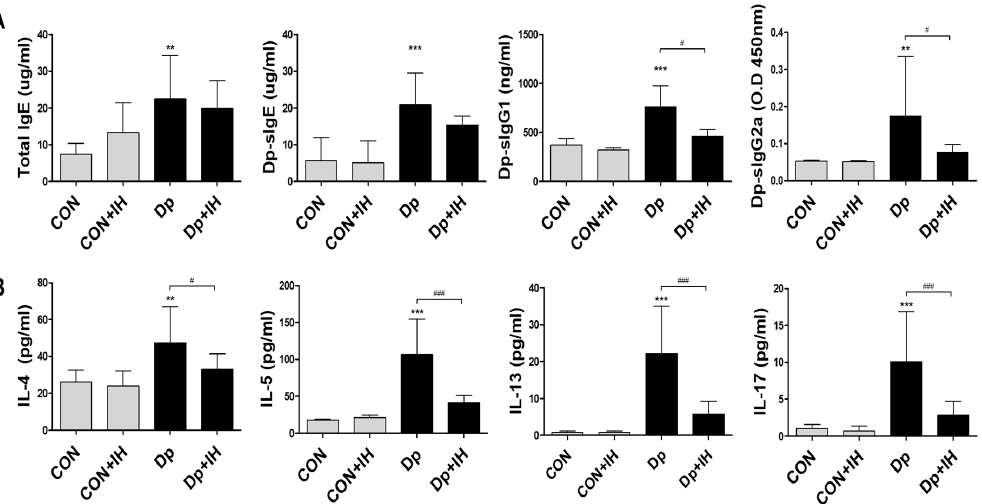
Figure 3. The level of Dp-specific immunoglobulin in serum and cytokine levels in BALF. ( A ) Serum IgE, Dp-specific IgE, IgG1 (at serum dilution of 1:1000), and IgG2a (at serum dilution of 1:10) were evaluated after the final administration of Dp. ( B ) Levels of IL-4, IL-5, and IL-13 were measured in the BALF by ELISA. Data shown are the mean ± standard deviation ( n = 7). ** p < 0.01 vs. CTL, *** p < 0.001 vs. CTL, # p < 0.05, ### p < 0.001.